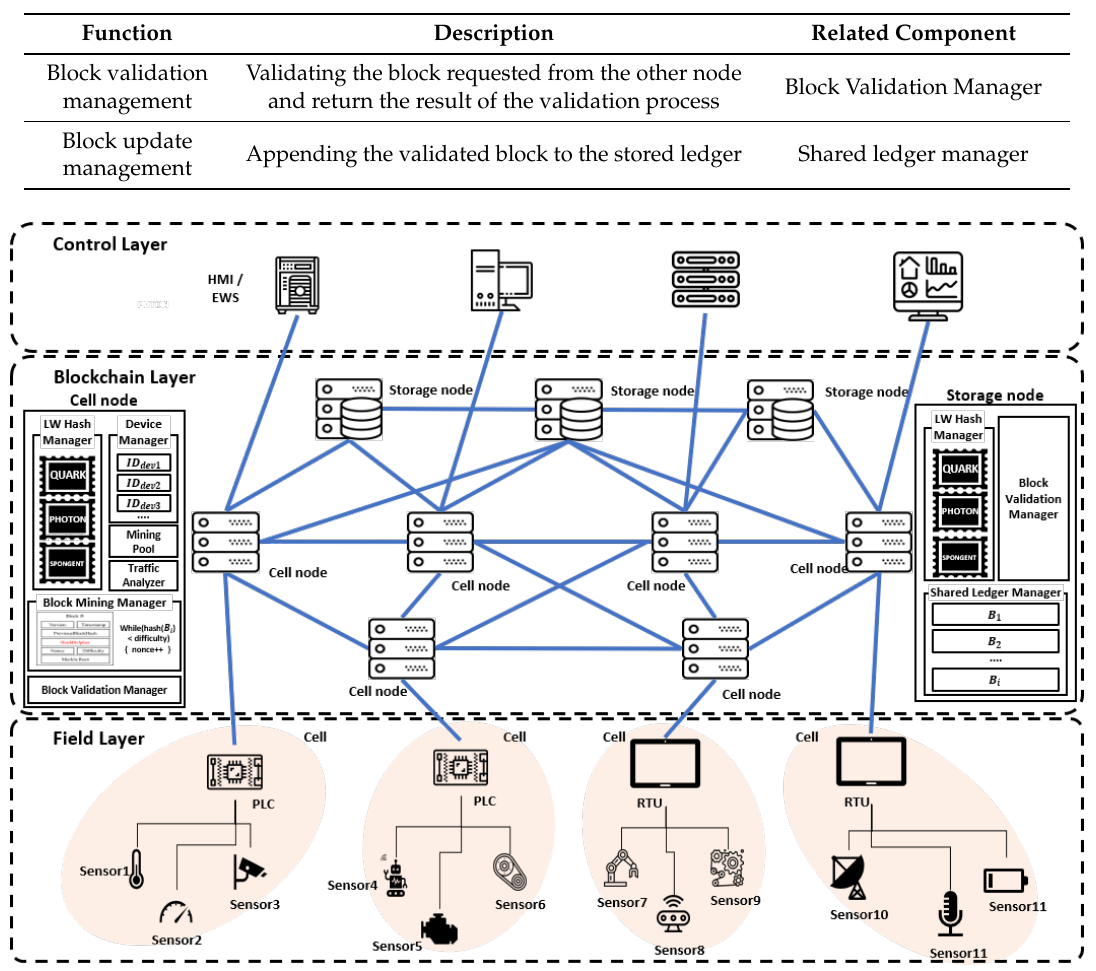
Table 4. Functions and related component of the storage node.